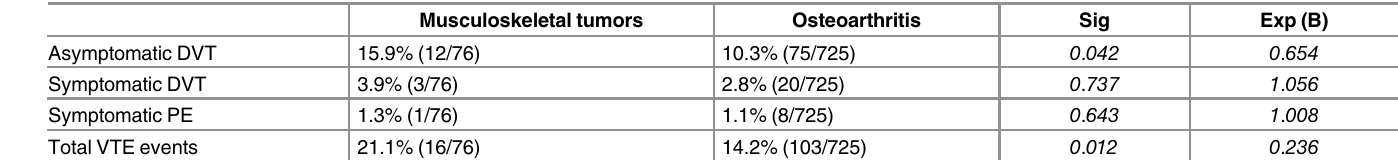
Table 6. Analysis of matched group as a potential risk factor of VTE with multivariate cox regression analyses. Musculoskeletal